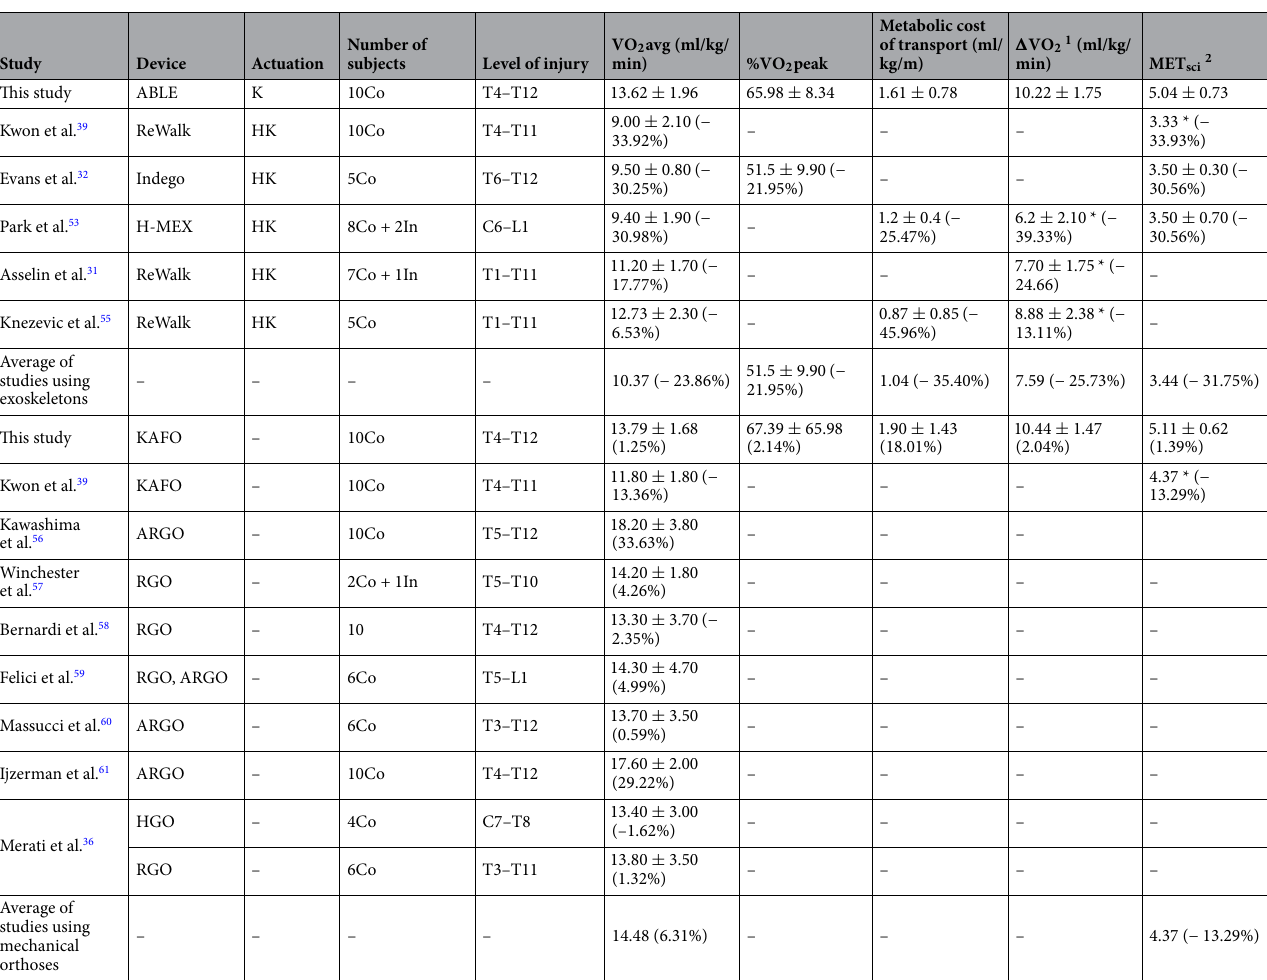
Table 2. Metabolic cost of walking with wearable exoskeletons and passive orthoses in previous studies and the present study. Values represent the mean and standard deviation. Values inside parentheses show the difference in percentage (%) with respect to the ABLE Exoskeleton